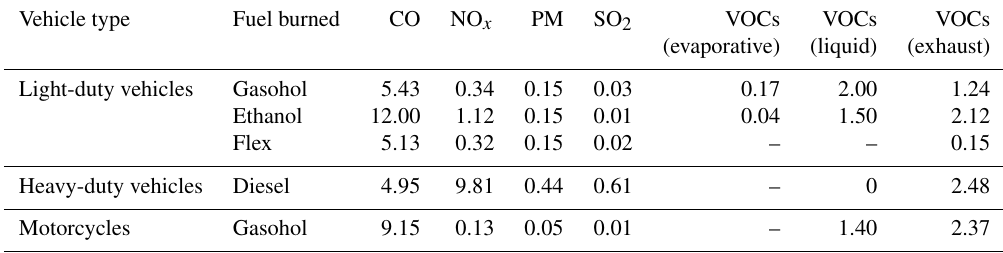
Table 2. Emission factors for CO, NO x , PM, SO 2 , and VOCs, in grams per kilometer, for different vehicle type–fuel combinations. Vehicle